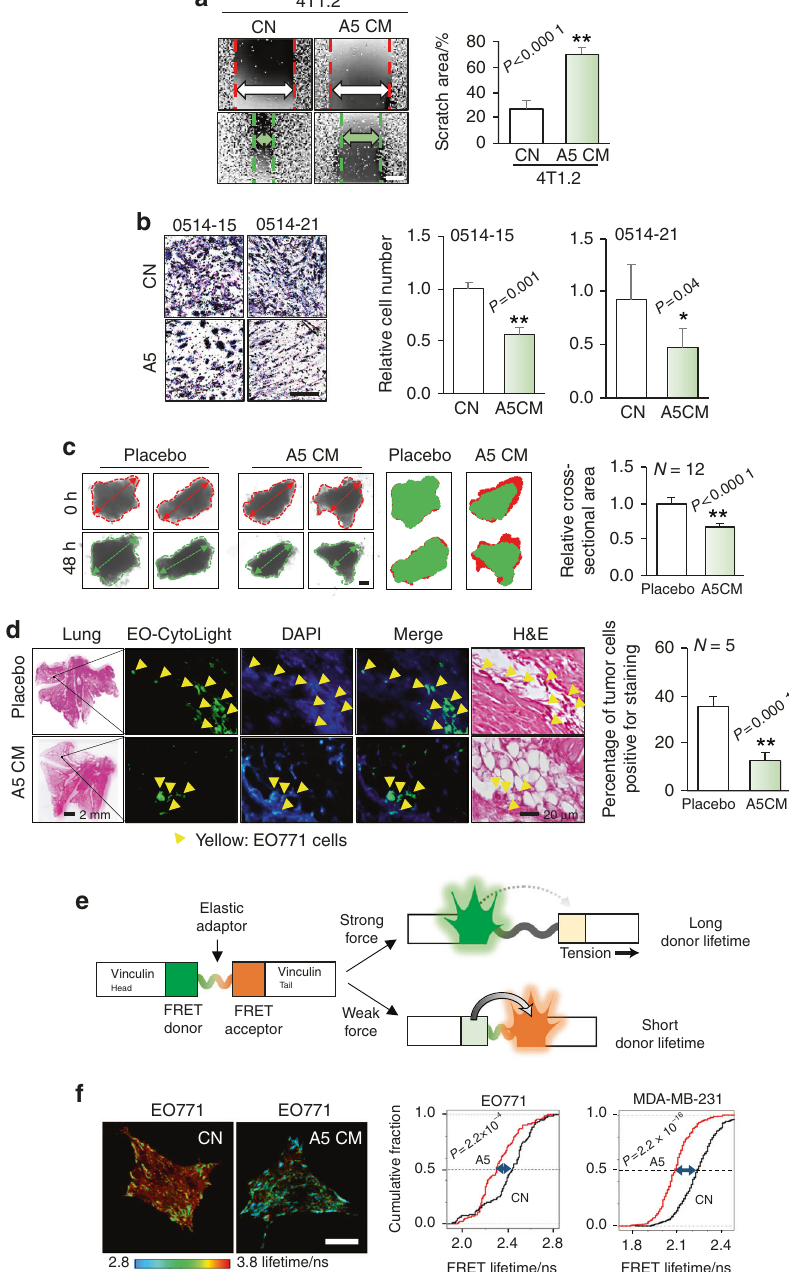
Fig. 2 Osteocyte-driven tumor-suppressive capabilities in vitro, ex vivo, and in vivo. CN control (plain medium), and CM conditioned medium. The single and double asterisks indicate P < 0.05 and P < 0.01, respectively. a Reduction in the migration (as assessed by a wound-healing assay) of 4T1.2 mammary tumor cells induced by A5 CM. Scale bar: 200 μ m. b Signi fi cant reduction in the invasion of primary human breast cancer cells from 2 sources after 48 h of treatment with A5 osteocyte-derived CM. Scale bar: 200 μ m. c Signi fi cant shrinkage of ex vivo breast cancer tissue fragments by A5 osteocyte-derived CM. The green image at 48 h is overlaid on the red image at 0 h. Scale bar: 200 μ m. d Signi fi cant reduction in the number of green fl uorescence-labeled EO771 mammary tumor cells (yellow arrows) in the lungs of C57BL/6 mice after coinjection with A5 osteocyte-derived CM in the extravasation assay. e Schematic diagram of a vinculin FRET biosensor: the tension- sensitive sensor consists of the head and tail domains of vinculin with an elastic FRET module. In response to a strong (or weak) force, the sensor exhibits a long (or short) donor lifetime. f A5 CM-driven signi fi cant reduction in the fl uorescence lifetime of a vinculin biosensor in EO771 and MDA-MB-231 cells. The observed reduction in the fl uorescence lifetime indicates A5 CM ’ s inhibitory effects on molecular force and cell migration. Scale bar: 20 μ Lrp5 deletion in osteocytes worsened tumor-driven osteolysis loss. Of note, Lrp5 expressed in tumor cells has a protumorigenic in vivo role, as mice injected with Lrp5-silenced EO771 tumor cells Having shown Lrp5 ’ s antitumor capability in osteocytes, we next showed a reduction in mammary tumor growth and tumor-driven examined the effect of Lrp5 deletion in osteocytes on tumor bone loss (Supplementary Fig. 4b, c).